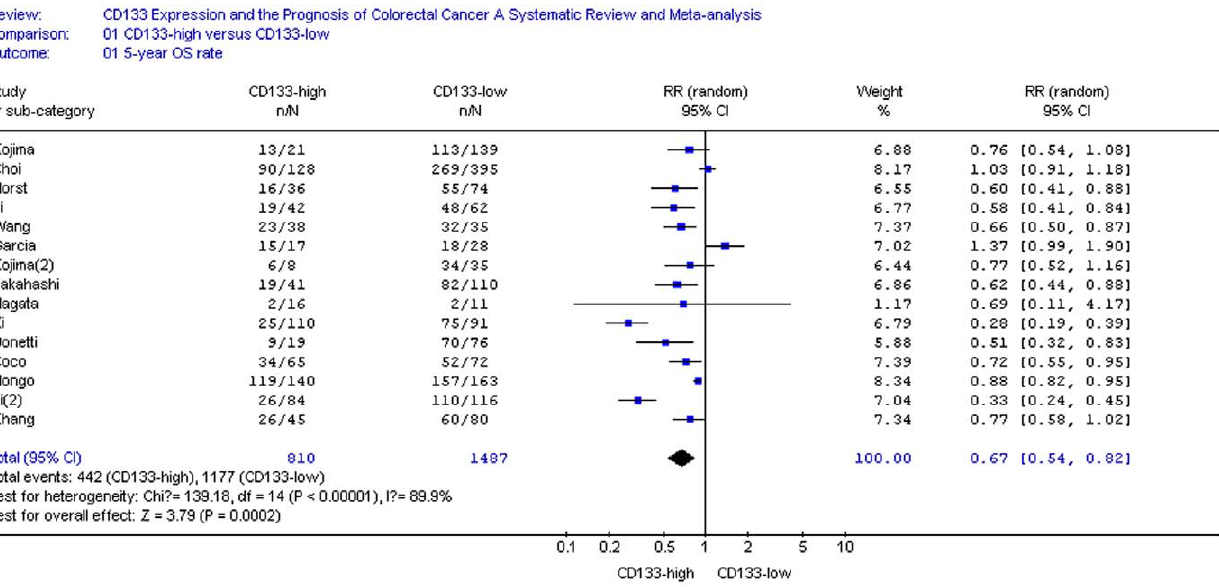
Figure 2. CD133 expression and 5-year OS rate.